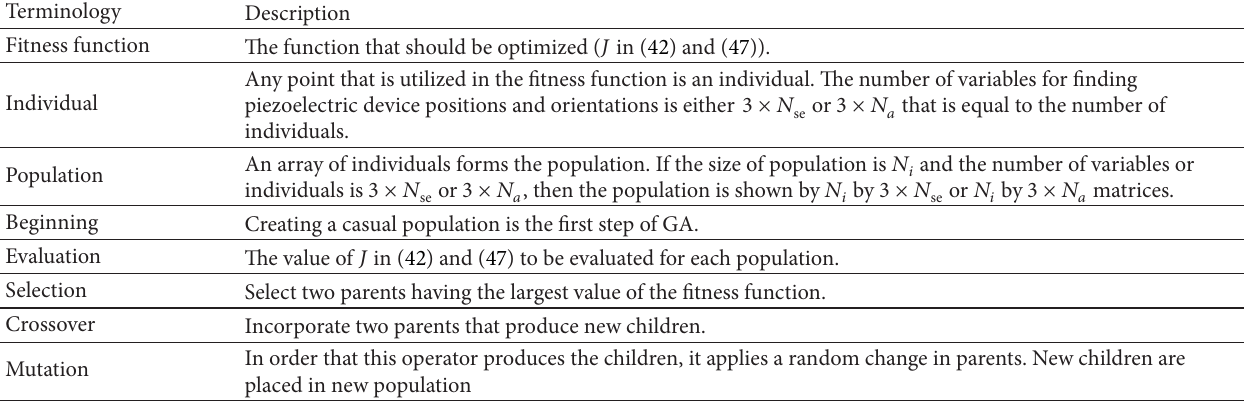
Table 1: Terminology for